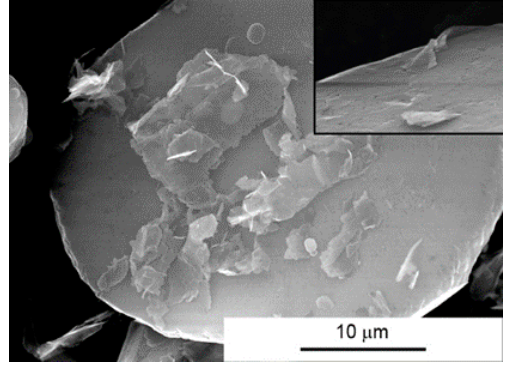
Figure 6. Morphology of AA6061/MLG powder mixture after homogenization.